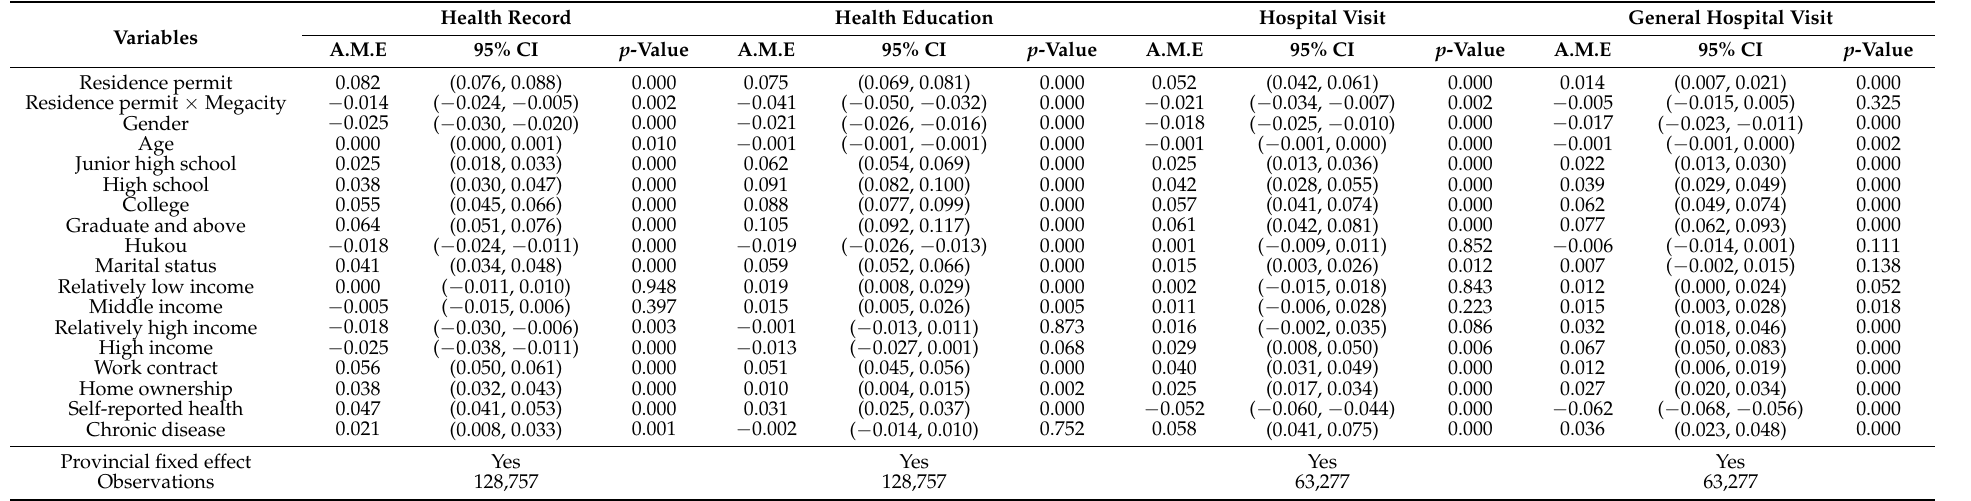
Table 4. Moderating effect of city size between residence permit and the utilization of health care